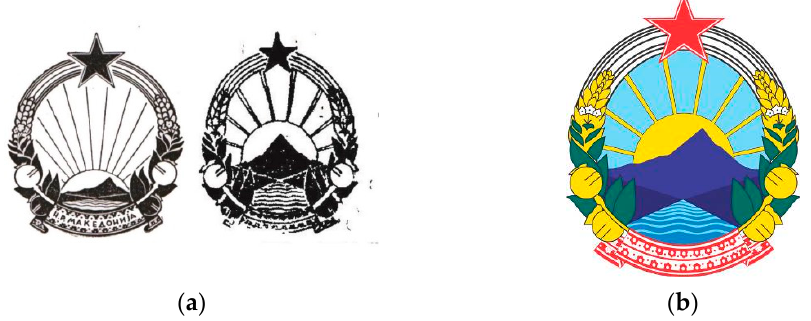
Figure 15. ( a ) Coat of arms of NRM from Official Gazette, 1946 and 1947; ( b ) Colored version of Popovic-Cico’s 1946 arms.